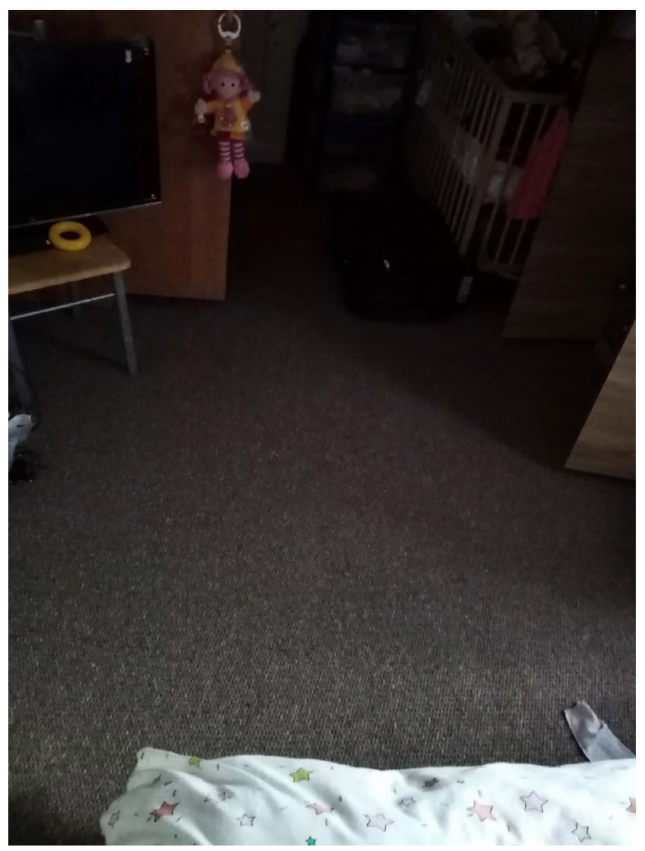
Figure 2. “That’s the space for my baby to